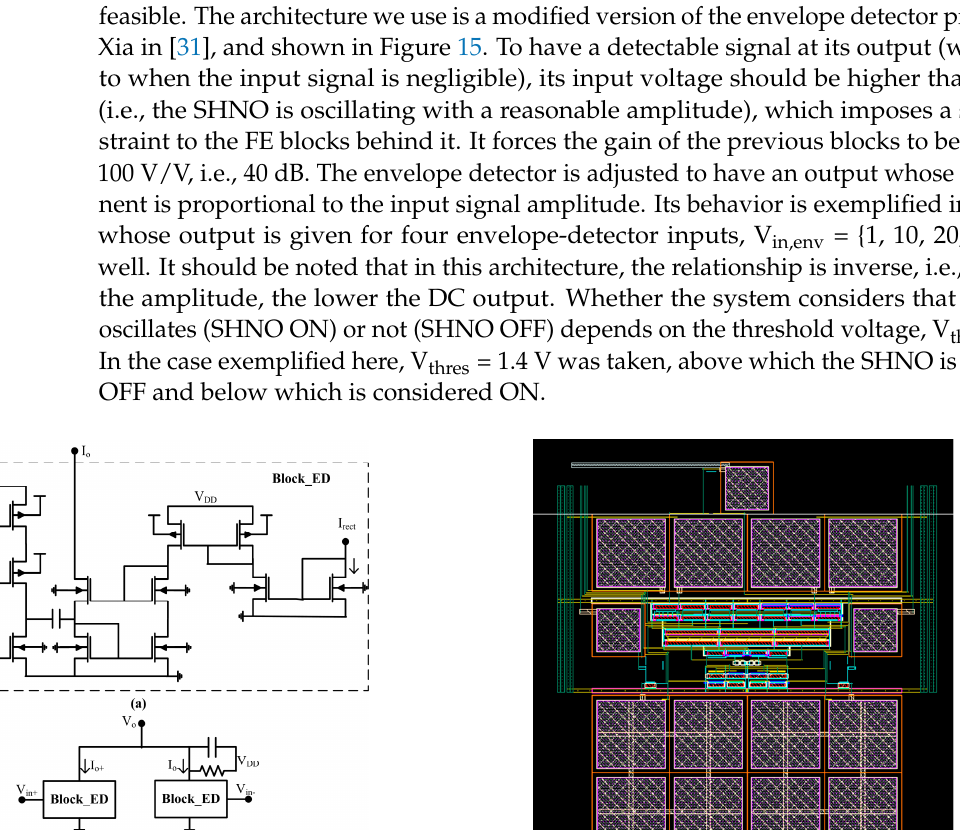
Figure 14. Transfer function (magnitude) of the IF amplifier.